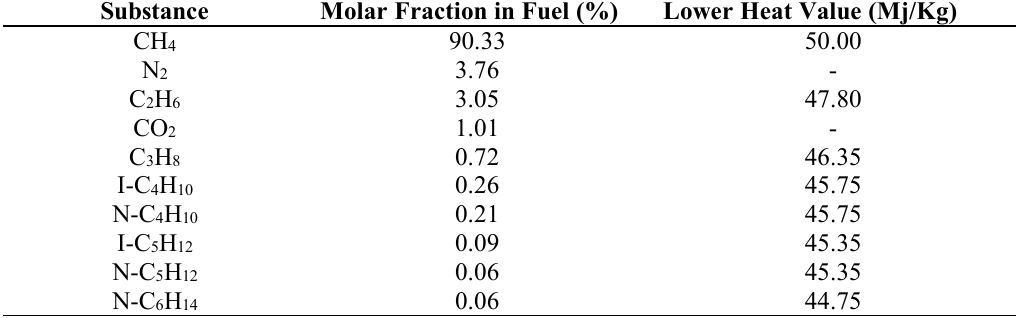
Table 4 . Molar fraction input natural gas in Polkalleh CS